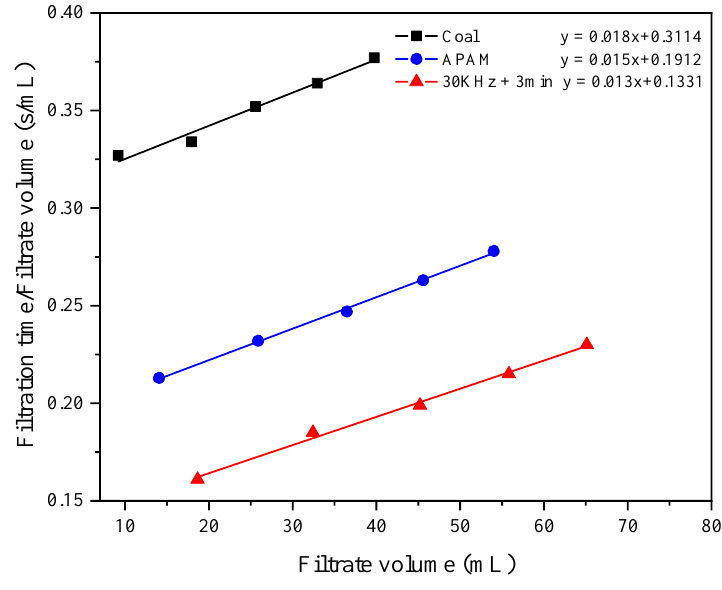
Figure 17. The fitting curve of Equation (2). Table 4. Results of Darcy’s theorem calculations under different conditions. Table 4. Results of Darcy’s theorem calculations under different